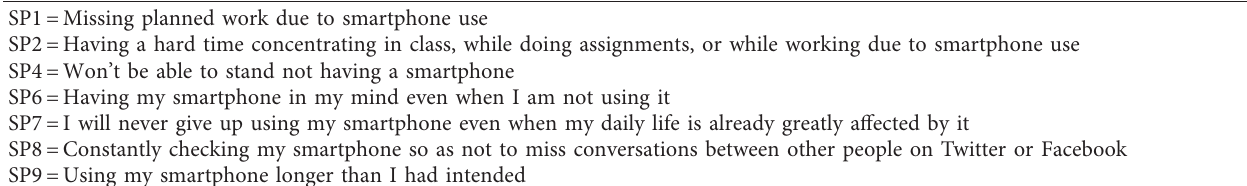
Table 4: Model variables.